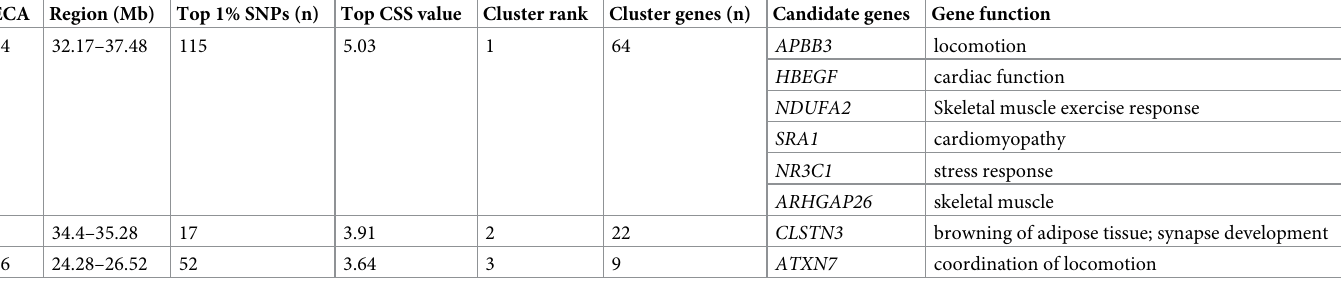
Table 2. Selected genomic regions among top 1% SNPs identifying core genes targeted by selection for the Australian racing phenotype (top 3 regions